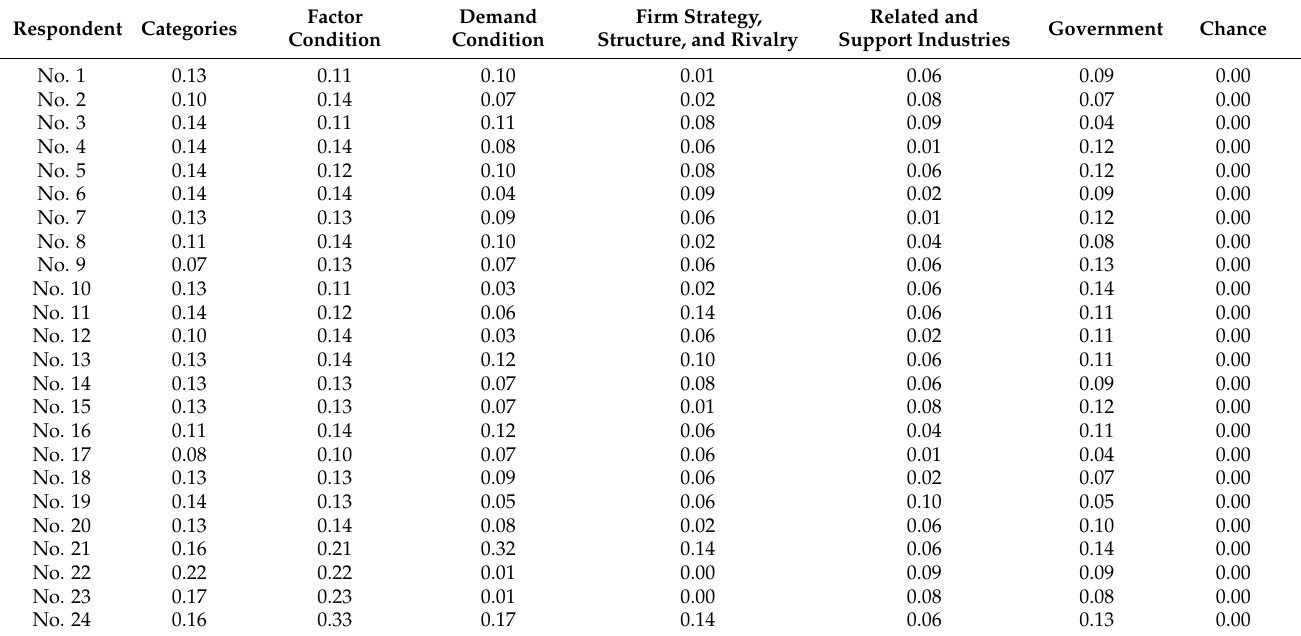
Table 4. Consistency ratio of each category for each respondent.